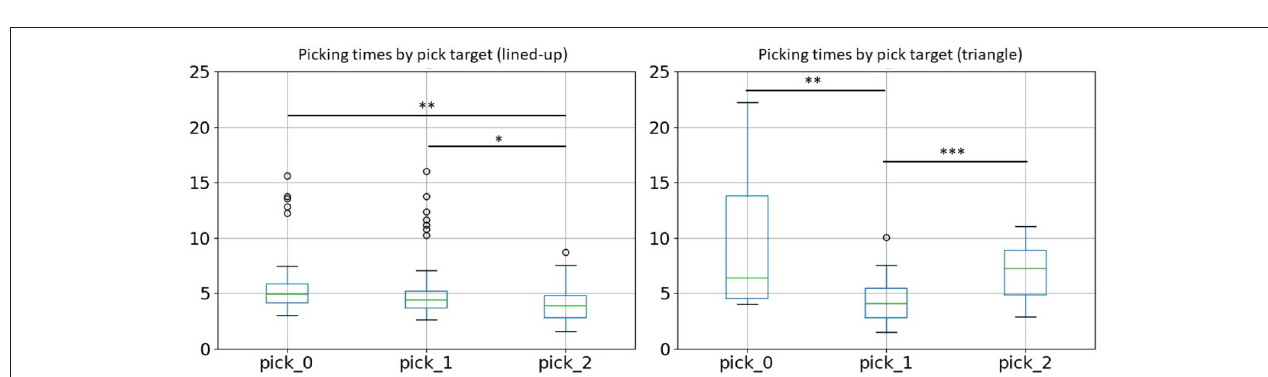
FIGURE 7 | Picking times across picking position for the two object configurations. The rearmost position requires a longer reaching time in both configurations, also due to difficult depth estimation. In the triangle configuration the forefront position on the left (pick_2), besides the rearmost position (pick_0), requires a longer picking time.